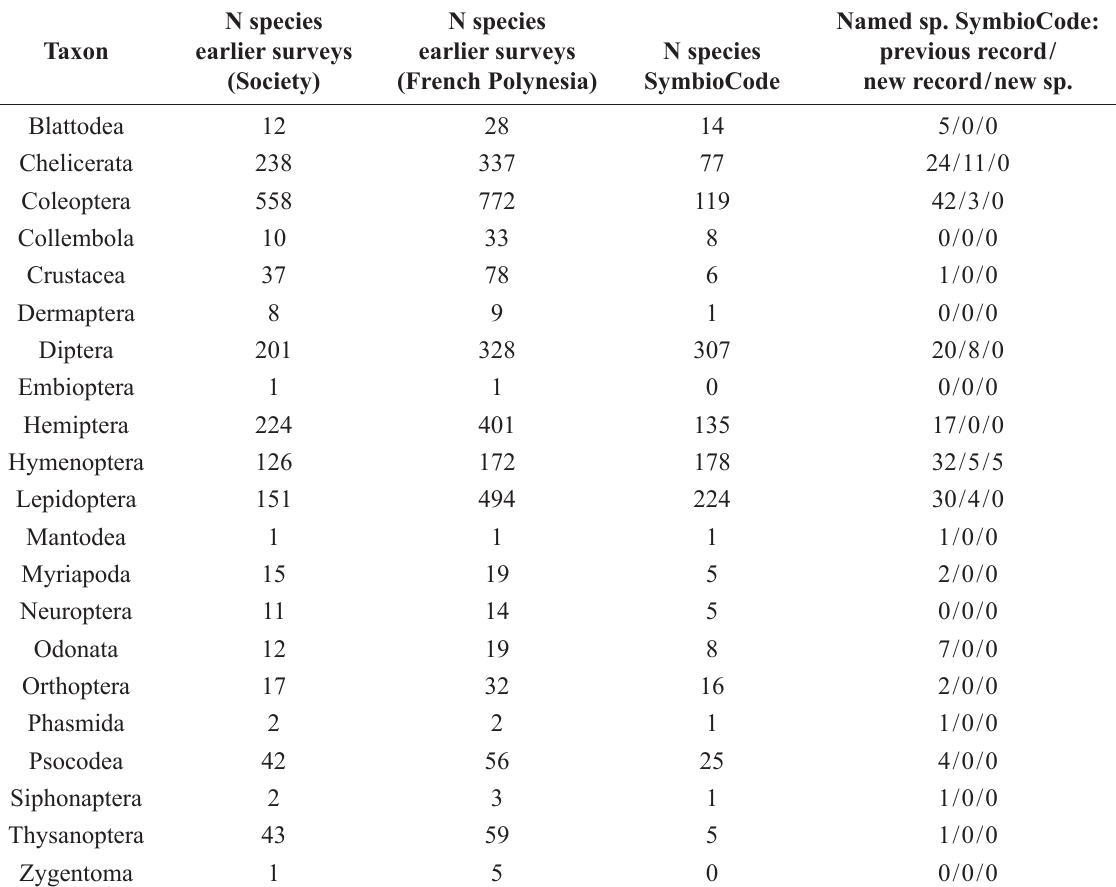
Table 3. Species counts in this study and in previous records from the Society Archipelago (based on Ramage